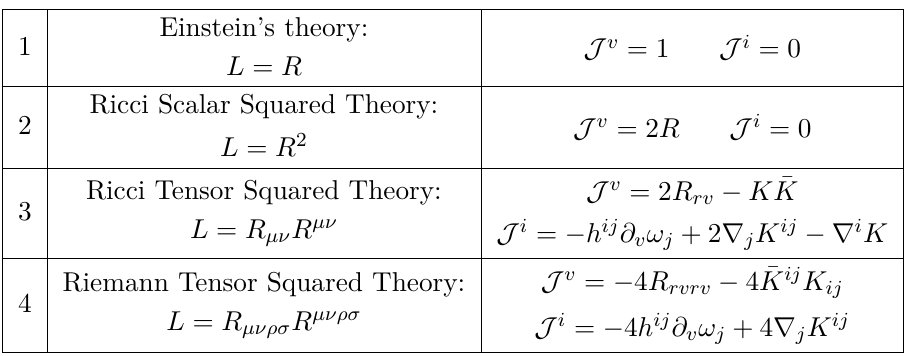
Table 7 . Entropy currents for Einstein gravity and other four derivative theories of